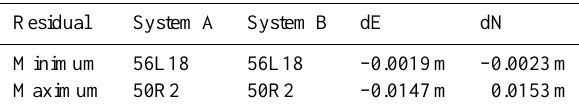
Table 7. Minimum and maximum residuals obtained from the transformation from Bolu to D¨uzce, piers 57 to